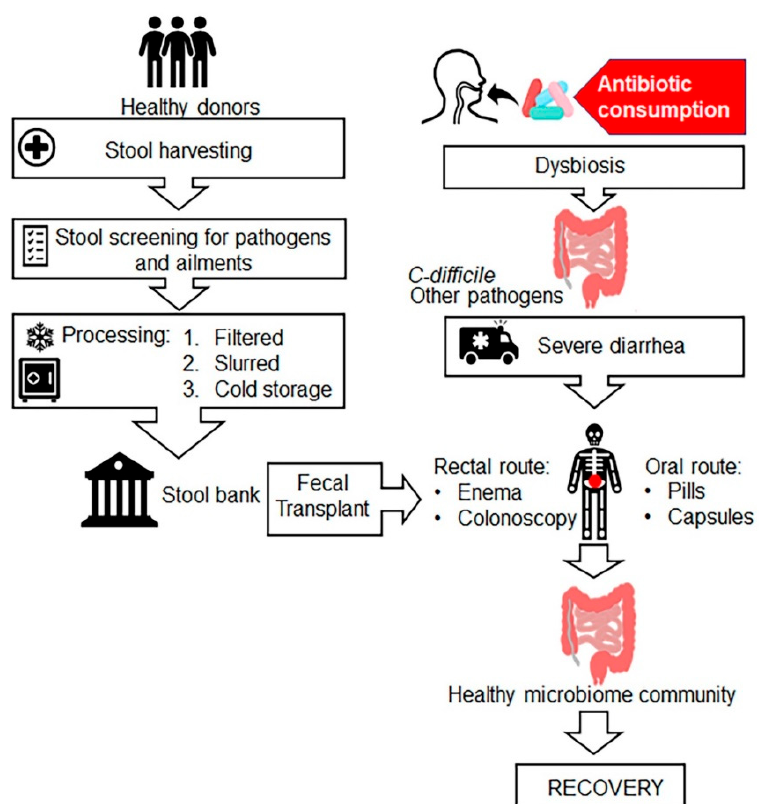
Figure 4. Schematic illustration of faecal microbiota transplantation (FMT) procedure. The left panel of the above figure depicts sample preparation where stool is harvested from healthy donors, processed via different stages such filtration, slurry preparation followed by cold storage in stool bank. The right panel illustrates the FMT procedure, where processed faecal microbiota of healthy donor stored in stool bank is either delivered via rectal route or oral route to the diseased patients (recipient) to provide a healthy microbiome community.